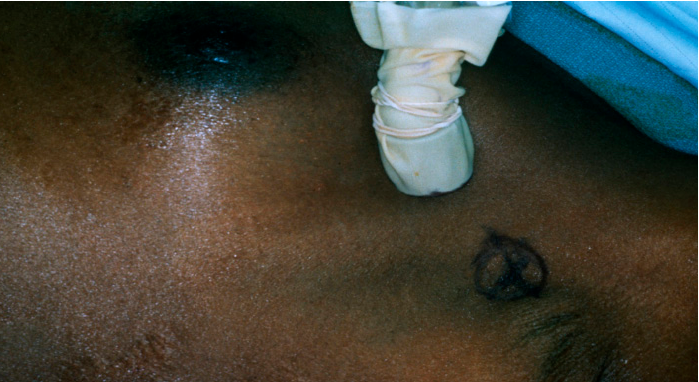
Figure 15. Intraoperative localization of a SLN using a Gamma Probe (Neoprobe 1500, Neoprobe Corp., Dublin, OH, USA). The mark on the skin of the axilla was made following lymphoscintigraphy.